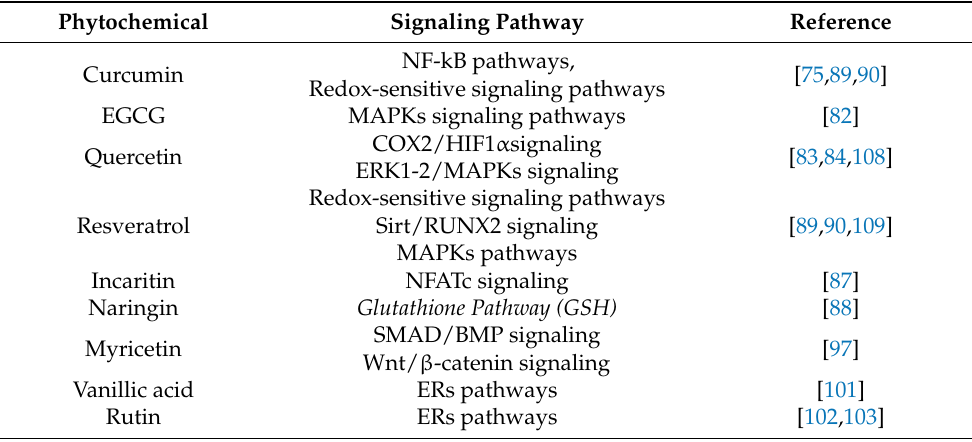
Table 1. Summary of phytochemical signaling pathways for bone regeneration. Phytochemical Signaling